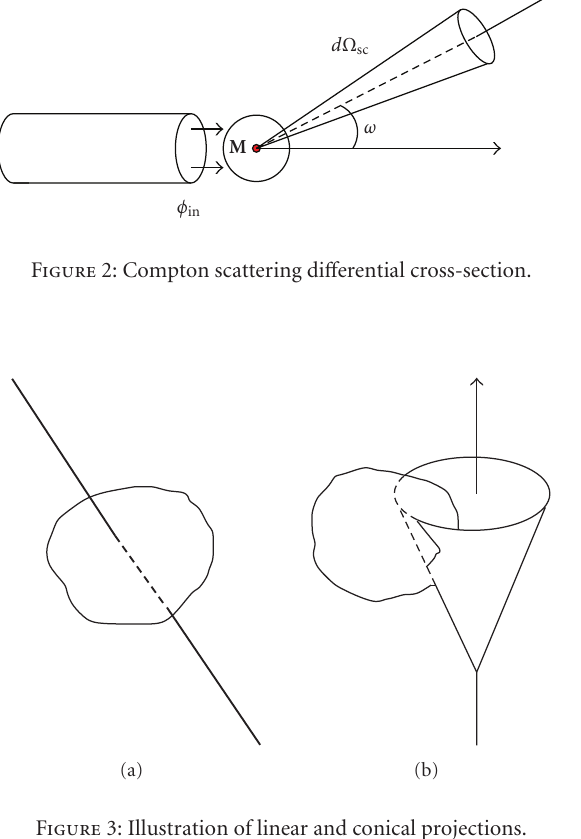
Figure 3: Illustration of linear and conical